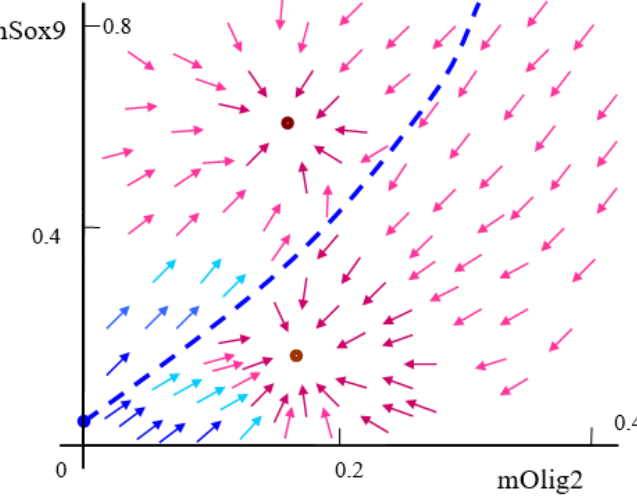
= = I I . Dashed blue line re- 2 1